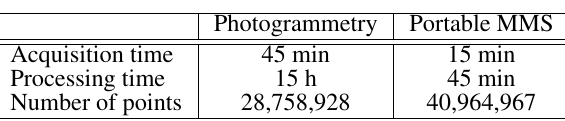
Figure 7. Reconstructed 3D model of the temple of Bziza and its surroundings, obtained via photogrammetric process (a) and using a handheld MMS (b).